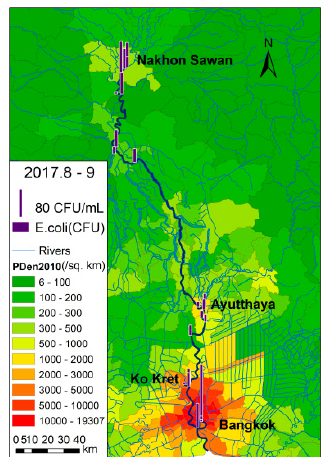
Figure 8. The distribution of E. coli in the latter half of the rainy season.